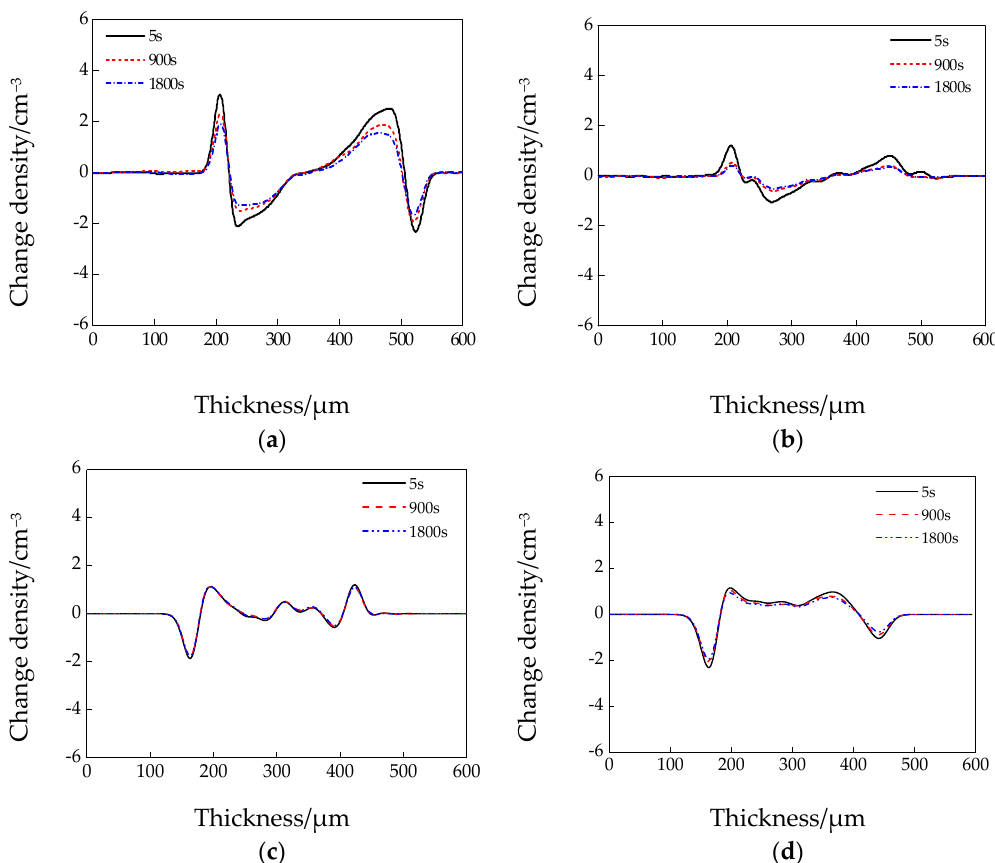
Figure 5. Space charge decay in the four samples under the short-circuit treatment: ( a ) LDPE, ( b ) N3, ( c ) M3, ( d ) N3M2.